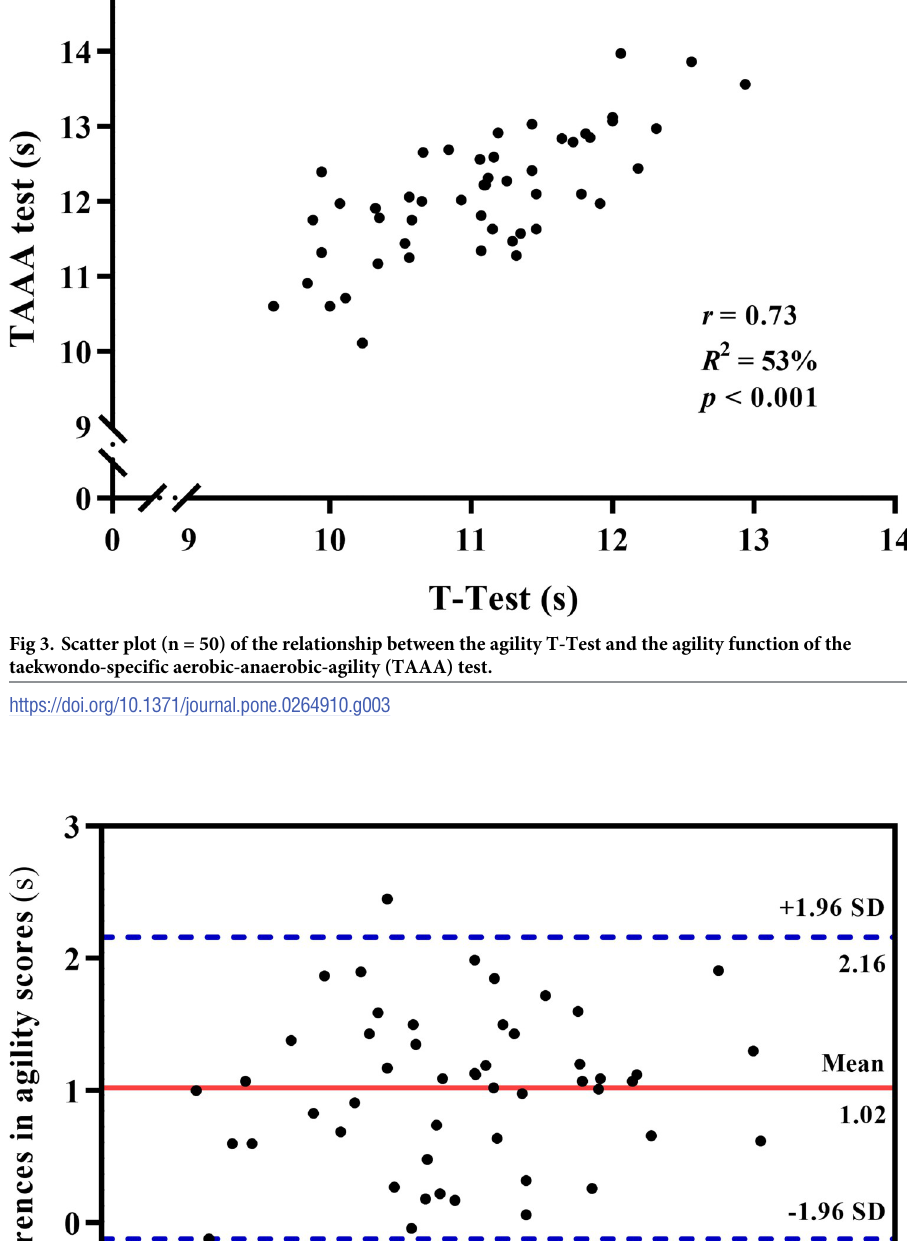
PLOS ONE | https://doi.org/10.1371/journal.pone.0264910 March 16,